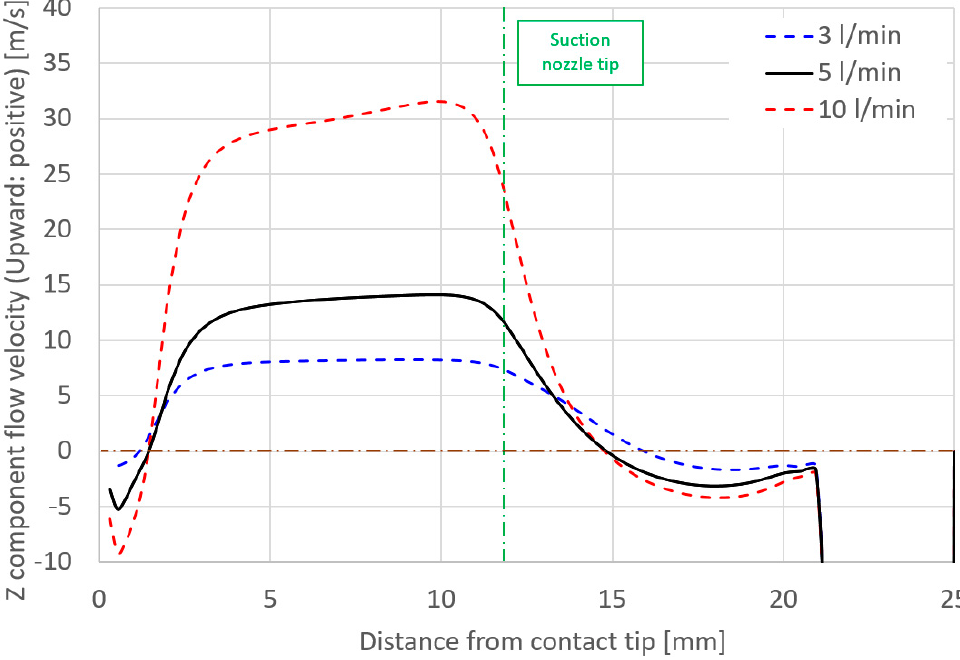
Figure 11. Axial distribution of Z component flow velocity as a function of the suction rate.